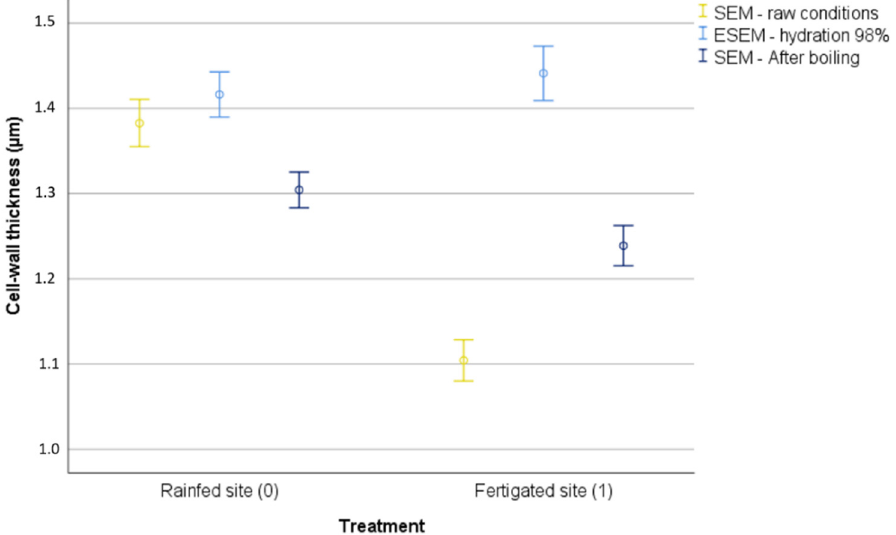
Figure 3. Mean ± standard deviation of cell wall thickness with regard to raw conditions, hydrated conditions, and after the boiling stage, for cork samples from the rainfed site (0) and the fertigated site (1).